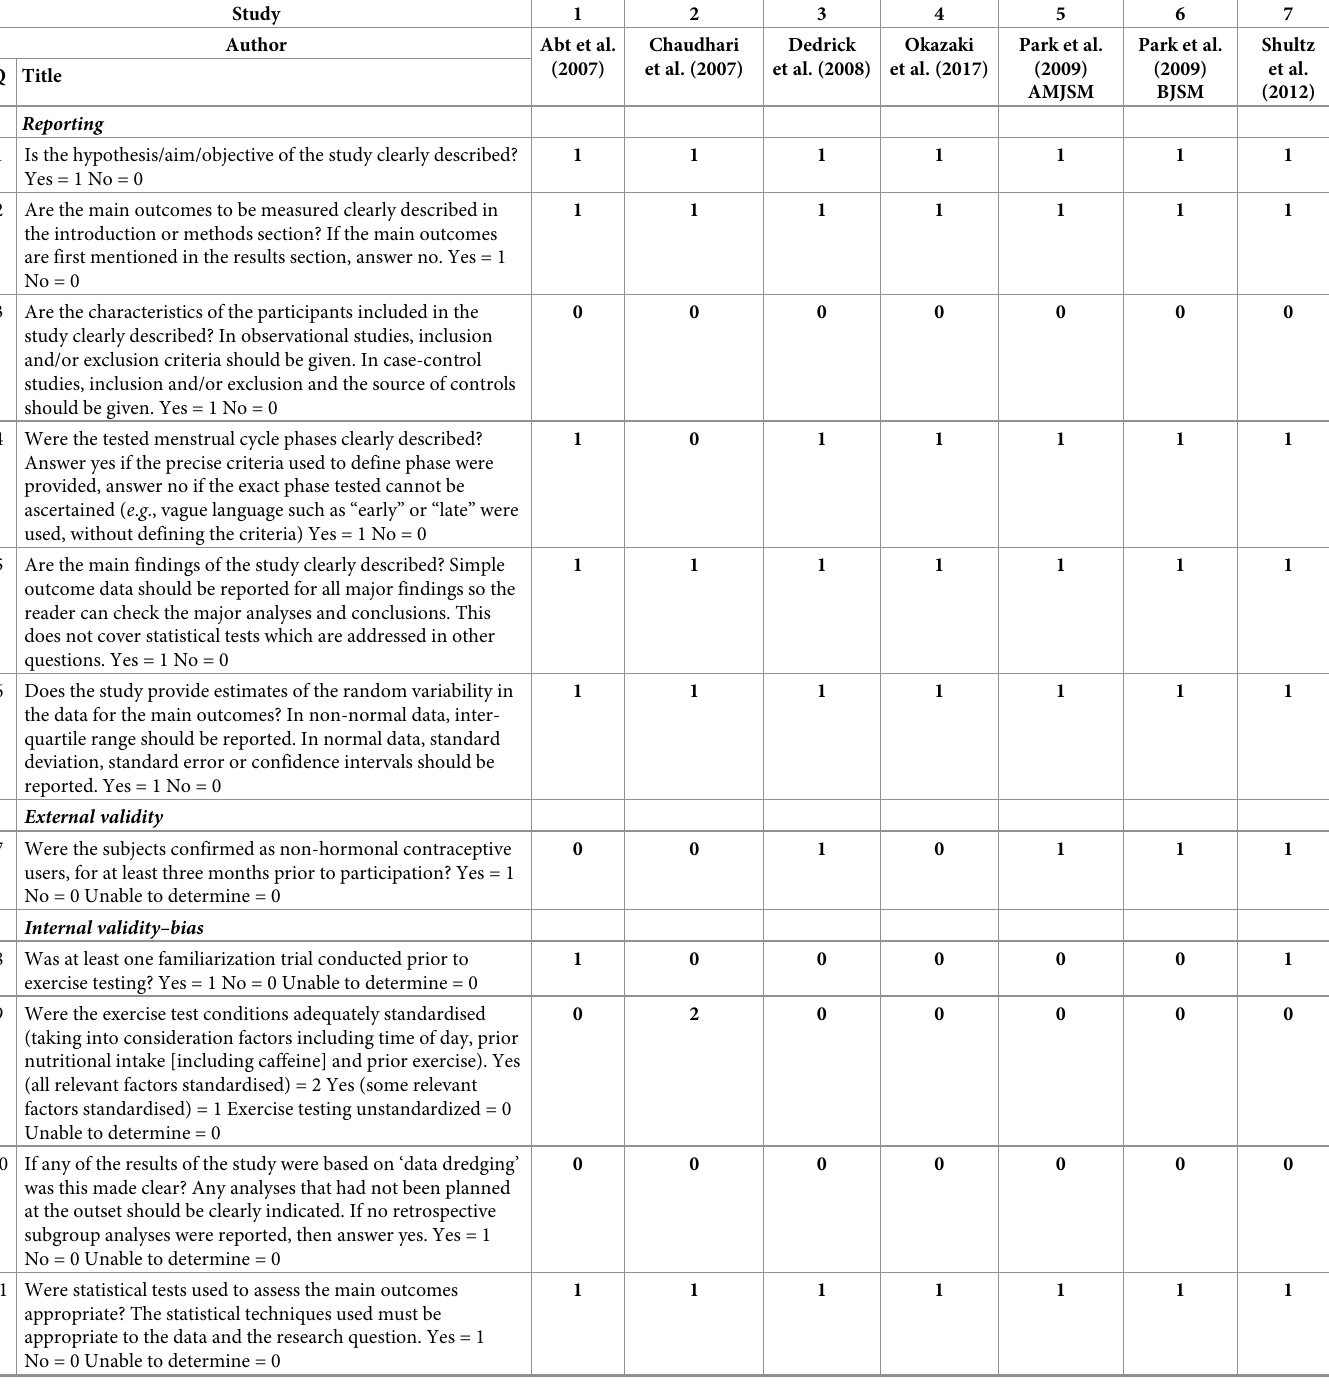
Table 2. Methodological quality assessment of included studies and quality of